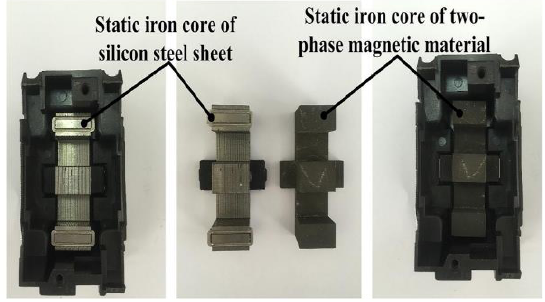
Figure 4. The core of circuit breaker with leakage protection of nano-two-phase magnetic material.